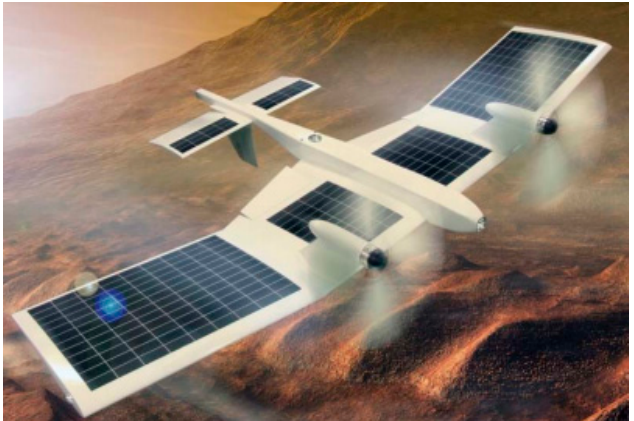
Figure 1. Flight image of the Mars exploration airplane.